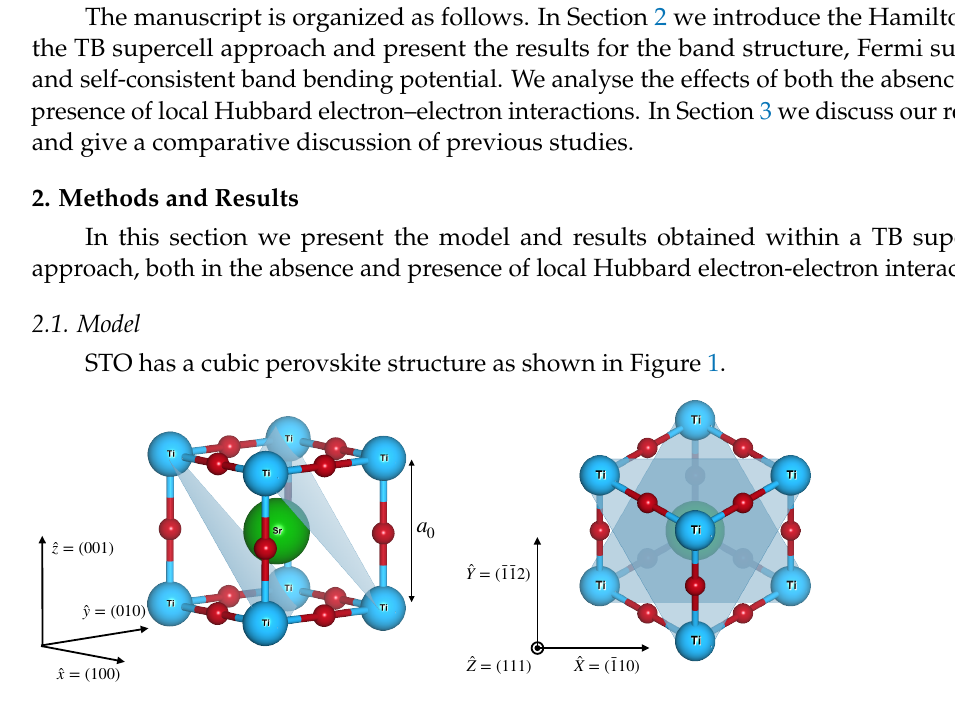
Figure 1. ( Left panel ) Crystal structure of SrTiO 3 . The structure is cubic with a lattice parameter of a 0 = 0.3905 nm. The blue dots represents the Ti atoms, the red dots the oxygen atoms, and the